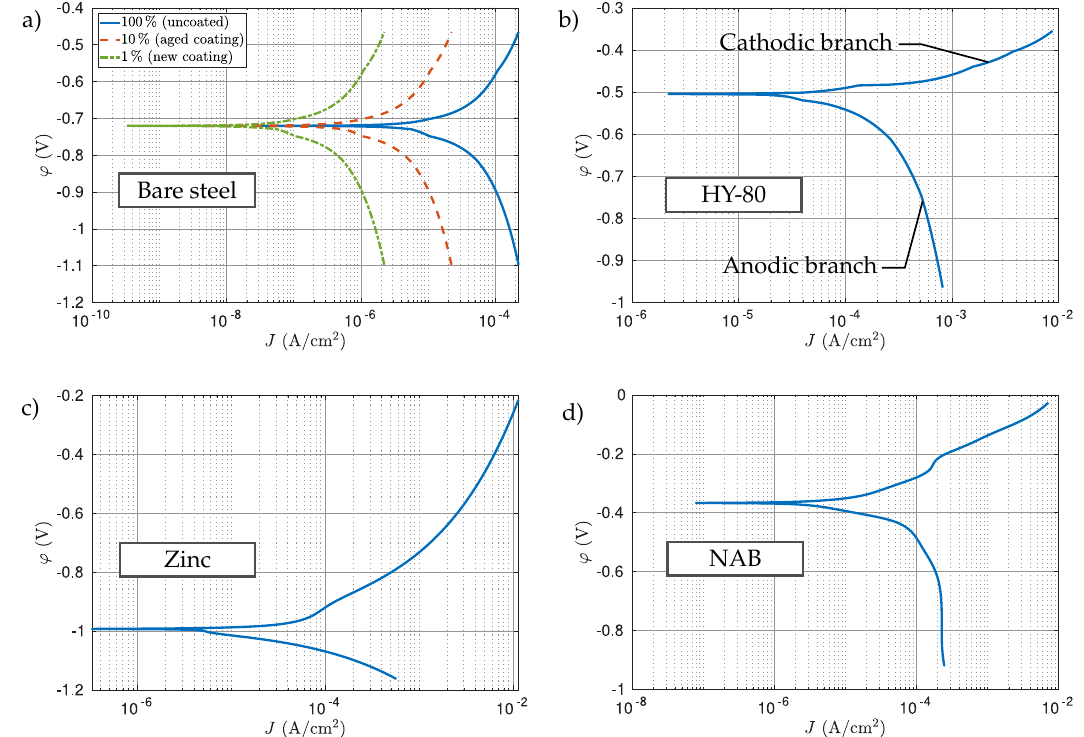
Figure 3. Polarization curves defined as electric potential ϕ over electric current density J for the subfiguresv ( a – d ) are used as boundary conditions for the numerical ship model in COMSOL. The polarization curve can be separated into the cathodic branch and the anodic branch as depicted in ( b ), with the former representing a positive current density pointing towards the material surface and the latter representing negative current densities flowing outside the material surface. The transition between both branches defines the equilibrium state, in which the number of oxidation and reduction reactions are equal. For the stated equilibrium the current density will be zero. All polarization data were taken from [7] and were recalculated for an Ag/AgCl reference electrode when the reference electrode differed from the Ag/AgCl electrode. To account for a perforated coating a correspondingly weighted current density of the polarization curve is applied as can be seen in ( a ). As an example, 10% shall represent a hull coating with a homogeneous damage of